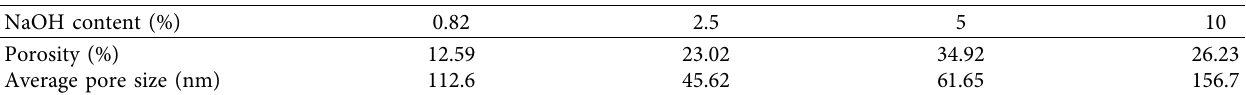
Table 3: Te pore structure parameters of the SFCM with diferent sodium hydroxide contents after curing at 90 ° C for 28d. NaOH content (%) 0.82 2.5 5 10 Porosity (%) 12.59 23.02 34.92 26.23 Average pore size (nm)